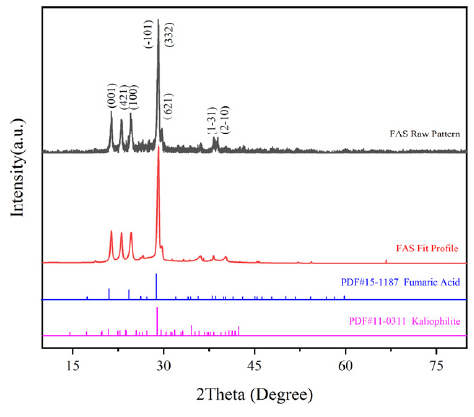
Figure 4. XRD spectrum of